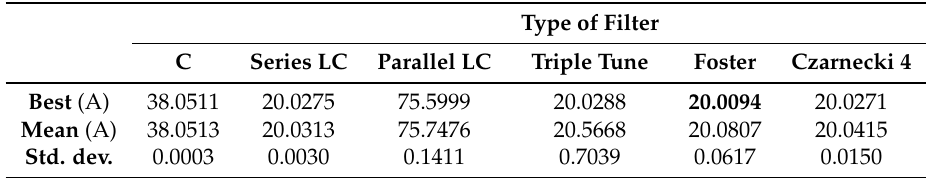
Table 2. Compensated RMS current ( I scp ) obtained by the genetic algorithm in Castro-Nuñez and Castro-Puche’s case study [22].